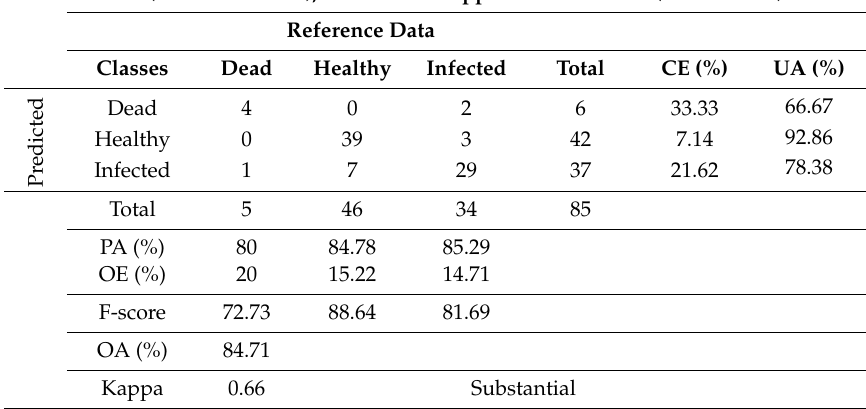
Table 6. Classification summary table and confusion matrix of tree health status derived from the support vector machine (SVM) using VI layers.